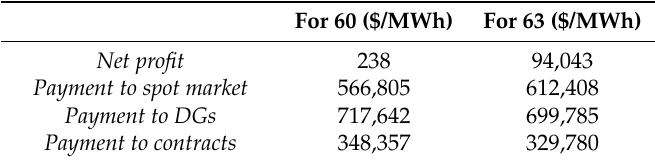
Table 12. Retailer’s profit and costs under different average selling prices in the fourth scheme.